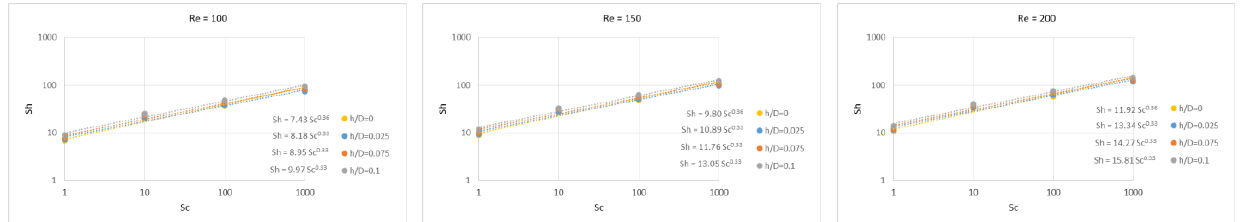
Figure 9. Theoretical predictions of Sh number dependence on Re number for various h/D values of the novel spacer and typical Re numbers.